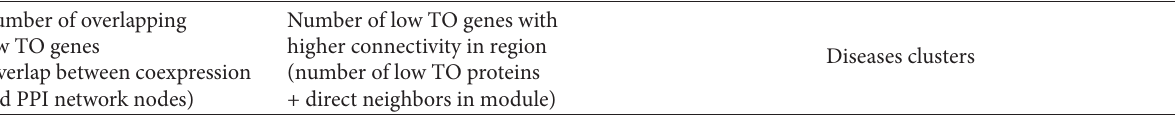
Table 5: Differential connectivity-disease association of the low TO gene modules (low TO proteins and their direct neighbors in the PPI